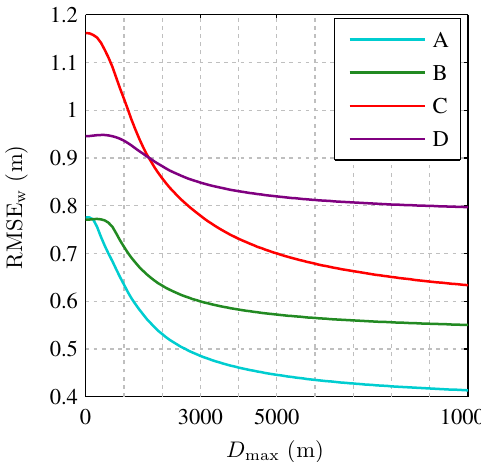
Fig. 7. The combined error metric RMSE w as a function of D max for predictions A, B, C and D. The larger D max , the more the re- quirement of an exact match is relaxed; for D max → 0, we have RMSE w → RMSE 0 and for D max → ∞ , we have RMSE w → RMSE 1